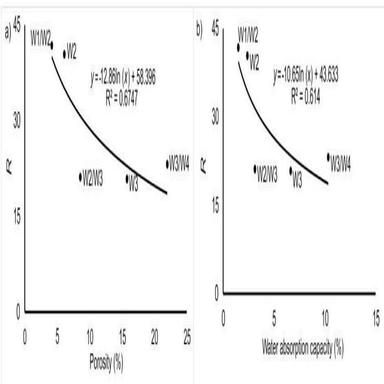
Correlations between R and porosity (a) and (b) water absorption capacity.